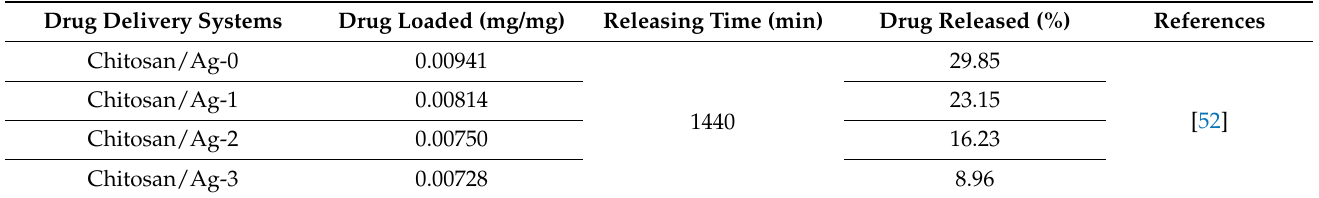
Table 3. Comparison of drug loading (mg/mg) and drug release (%) with similar studies. Drug Delivery Systems